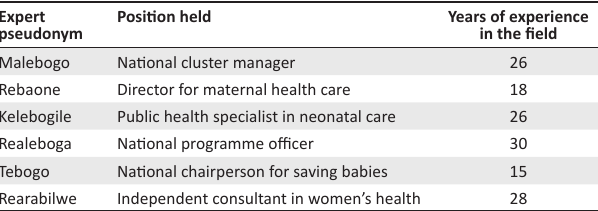
TABLE 1: The profile of reproductive health experts.